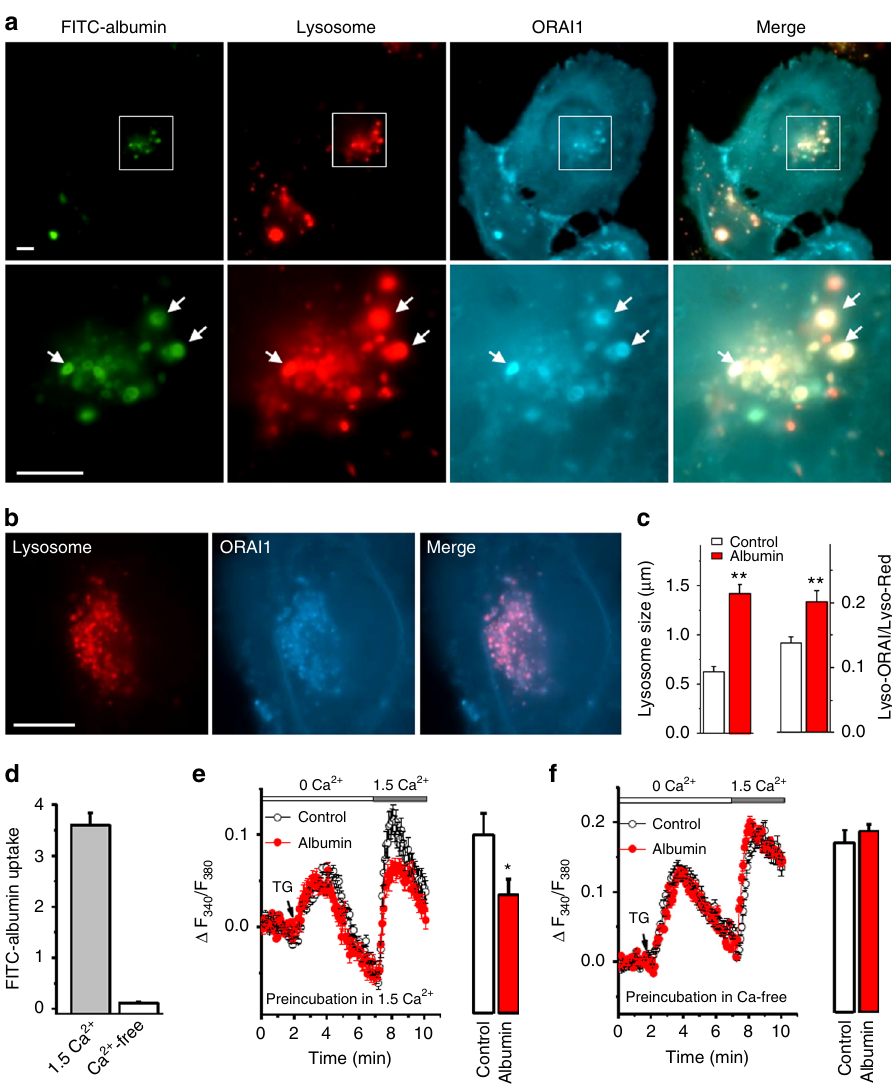
Fig. 4 Albumin endocytosis enhances ORAI1 channel internalization and impairs SOCE. a TIRF microscopy images showing human proximal tubular epithelial cells (PTECs) after incubation with FITC-albumin (50 µ g ml − 1 ) for 4 h. PTECs were transfected with ORAI1-tagged with CFP. Lysosomes were stained using LysoBrite Red. b The PTECs without FITC-albumin treatment. Scale bars, 10 µ m for ( a ) and ( b ). c Mean lysosome size and fl uorescence intensity (ratio of CFP-ORAI1 in lysosomes (Lyso-ORAI) to LysoBrite Red (Lyso-Red) ( n = 32 – 50). d FITC-albumin uptake in PTECs in 1.5 mM Ca 2+ bath solution ( n = 30) or in Ca 2+ -free solution with 0.4 mM EGTA ( n = 30). e Pre-incubation with FITC-albumin for 30 min in 1.5 mM Ca 2+ solution reduces store-operated Ca 2+ in fl ux in PTECs. Bar chart shows the mean data for the peak of SOCE in the FITC-albumin incubated ( n = 12) and control PTECs ( n = 16). f Unaffected SOCE when PTECs were pre-incubated with ( n = 13) or without ( n = 15) FITC- albumin for 30 min in Ca 2+ -free solution. Average data are presented as mean ± s.e.m. The data sets are compared by t test. Statistical signi fi cance is indicated by * P < 0.05, ** P <